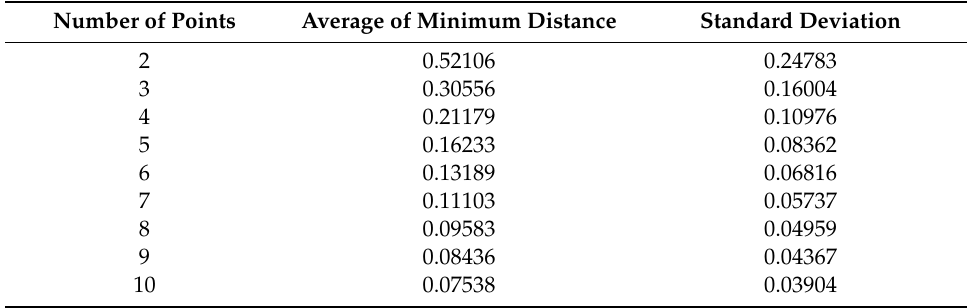
Table A1. Average of the minimum distances and standard deviations against the number of